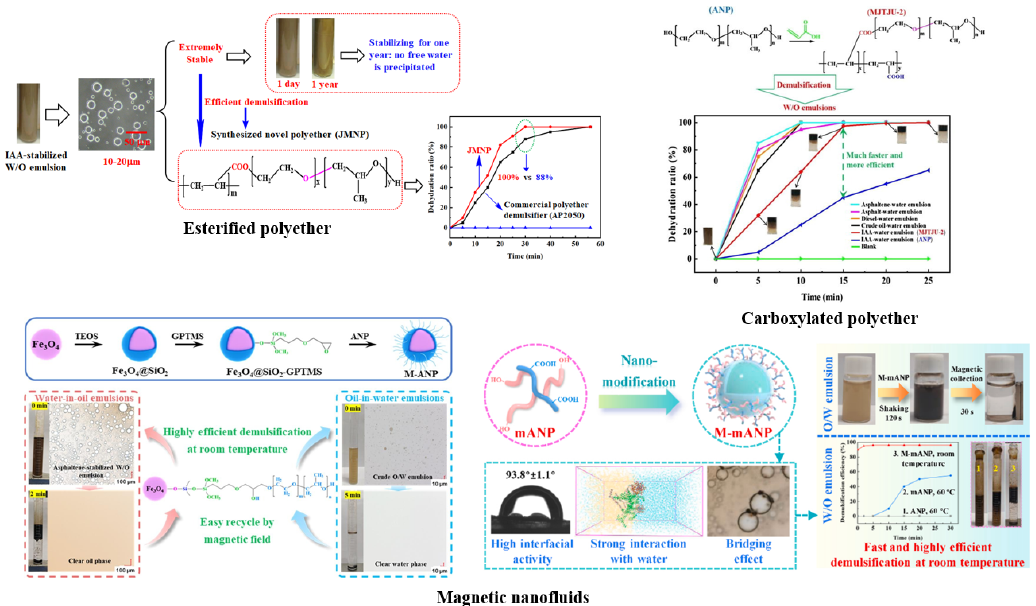
Figure 29. Application of new demulsifier in breaking heavy oil–water emulsions. Reprinted with